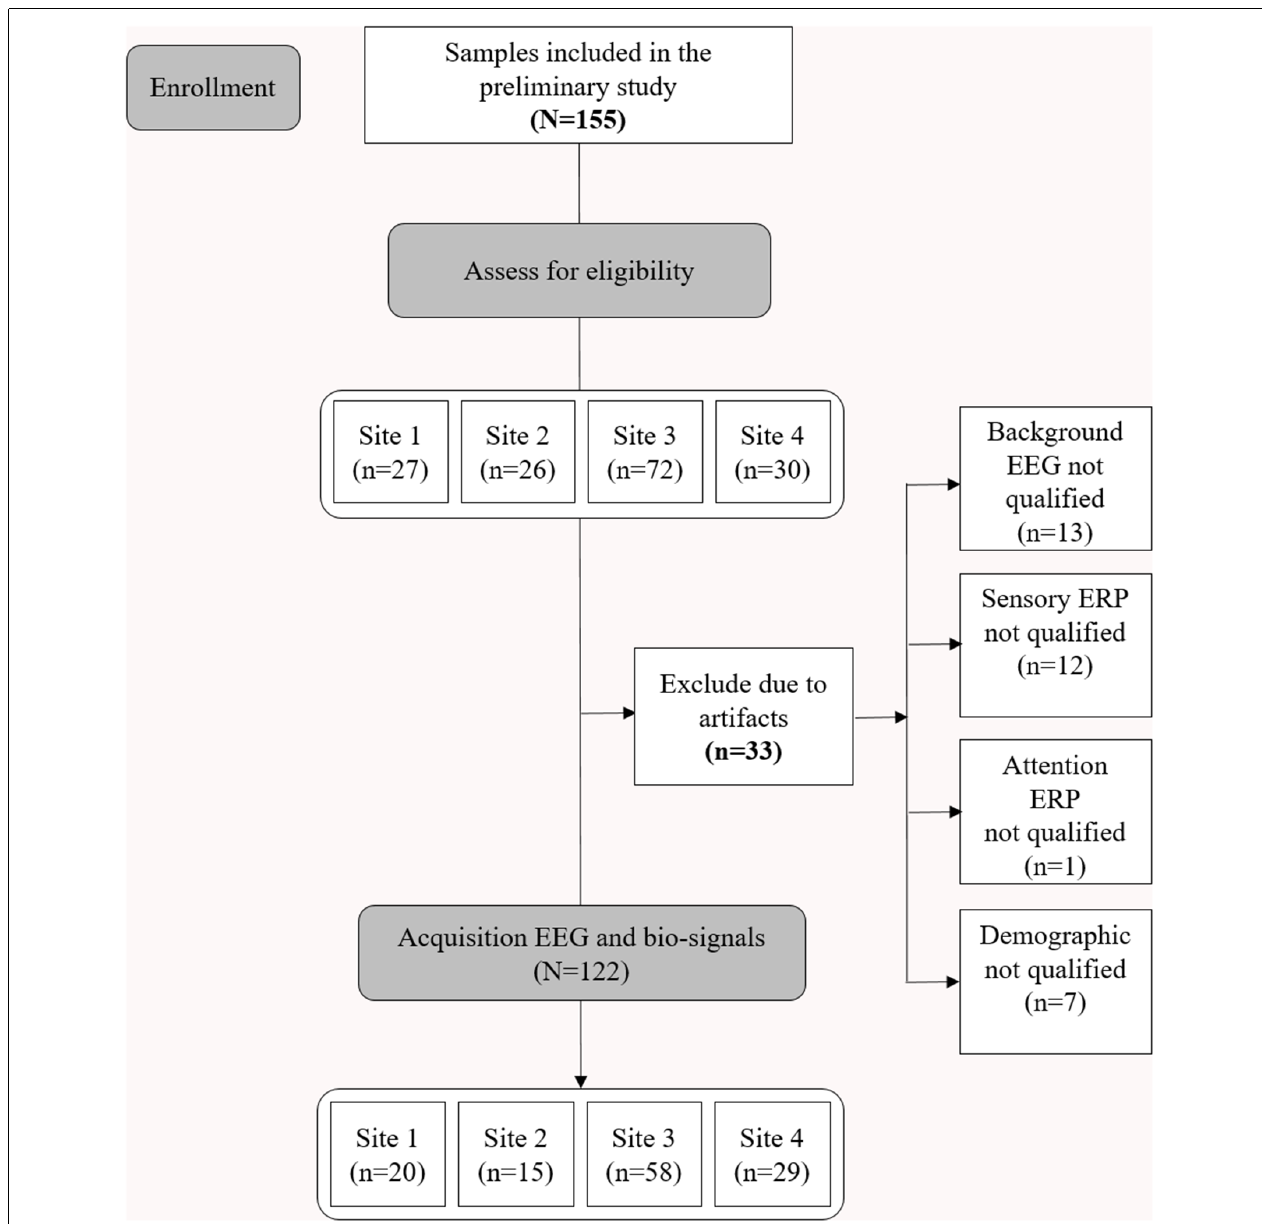
FIGURE 1 | Consolidated Standards of Reporting Trials (CONSORT) diagram illustrating enrollment and exclusion criteria for this study.